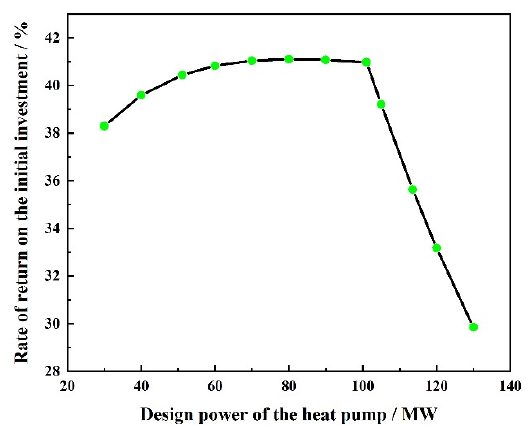
Figure 9. ROI at di ff erent design powers of the heat Figure 9. ROI at different design powers of the heat pump.